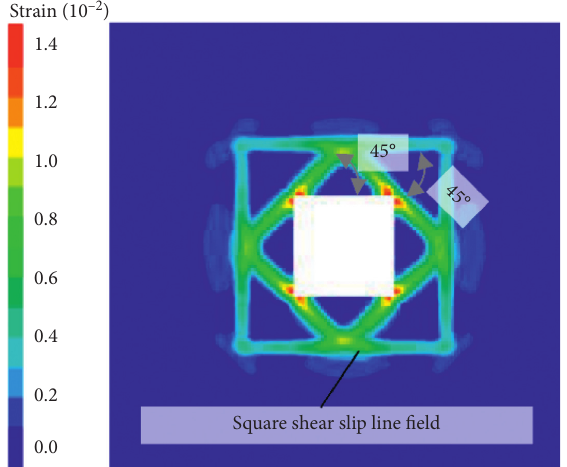
Figure 6: Nephogram of the shear strain of surrounding rock ( Ic � 1.5).